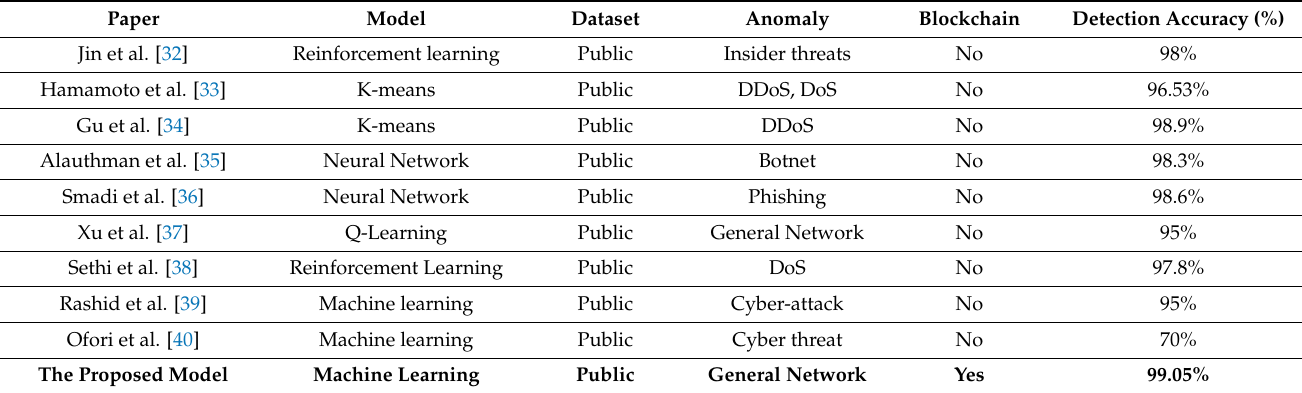
Table 11. Comparative analysis with previous